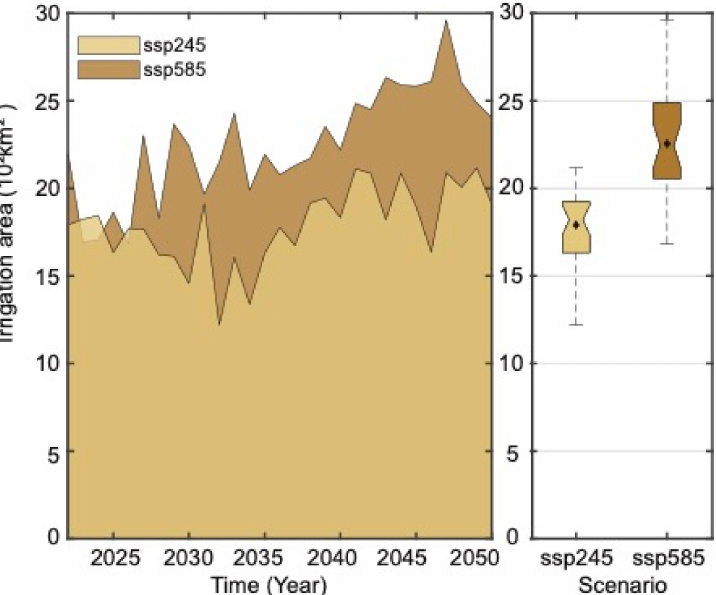
Figure 9. Annual available irrigation areas in the mainstream of the Tarim River from 2022 to 2050 under future climate scenarios SSP245 and